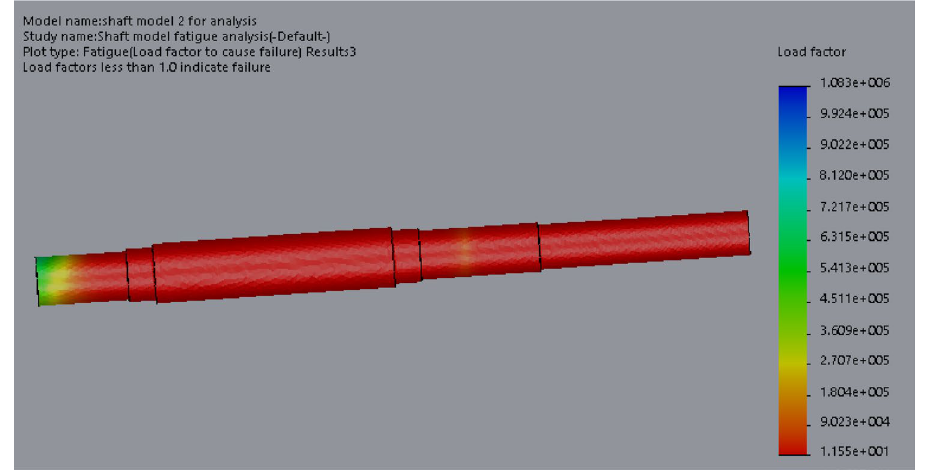
Figure 24. Fatigue load